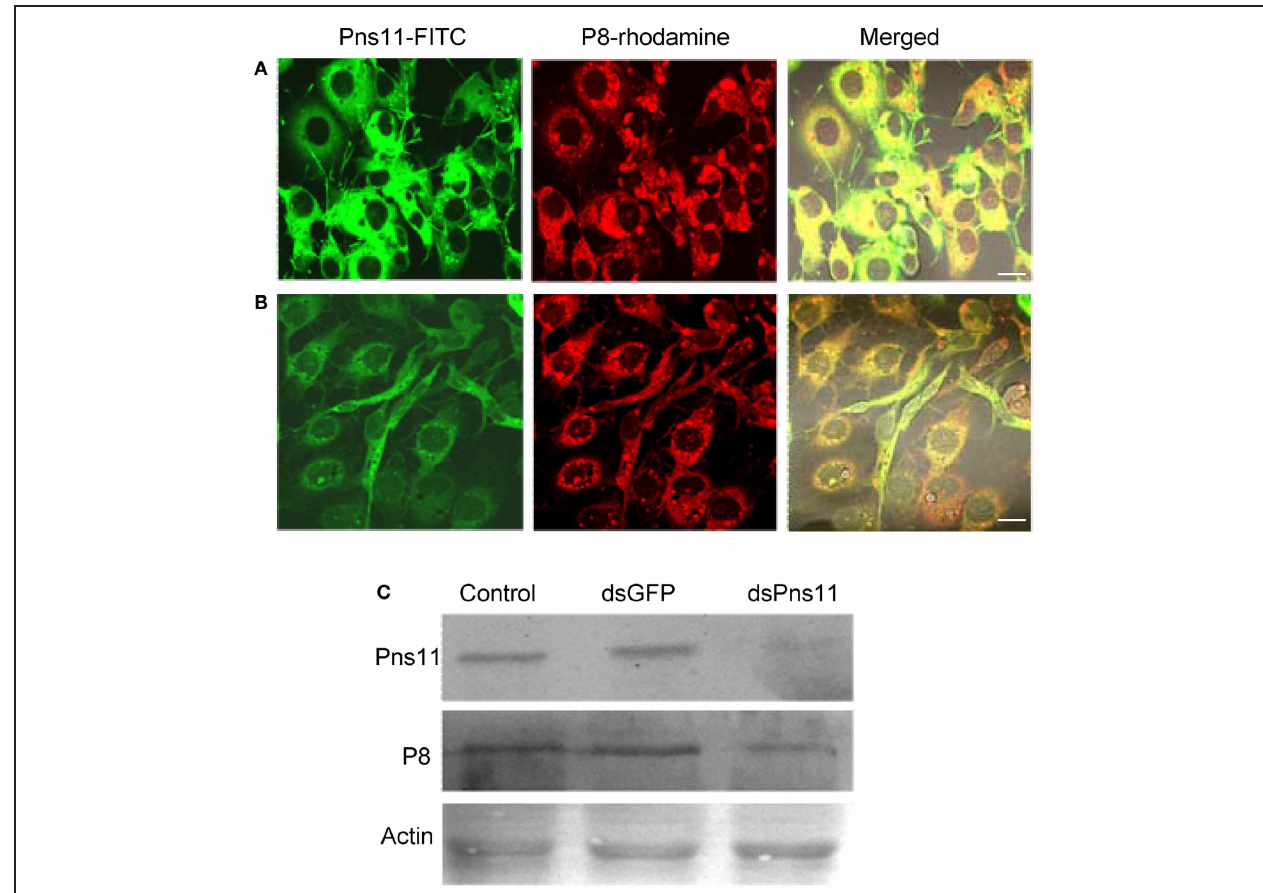
with multiple preparations. Bars, 30 µ m. (C) RNAi induced by dsPns11 significantly reduced the expression of Pns11 but not P8 of RGDV in virus-infected VCMs as shown here in Western blots. Protein extracts from cells transfected with Cellfectin, dsGFP or dsPns11 were separated by SDS-PAGE to detect Pns11 or P8 with Pns11-specific or P8-specific antibodies, respectively. Insect actin was detected with actin-specific antibodies as a